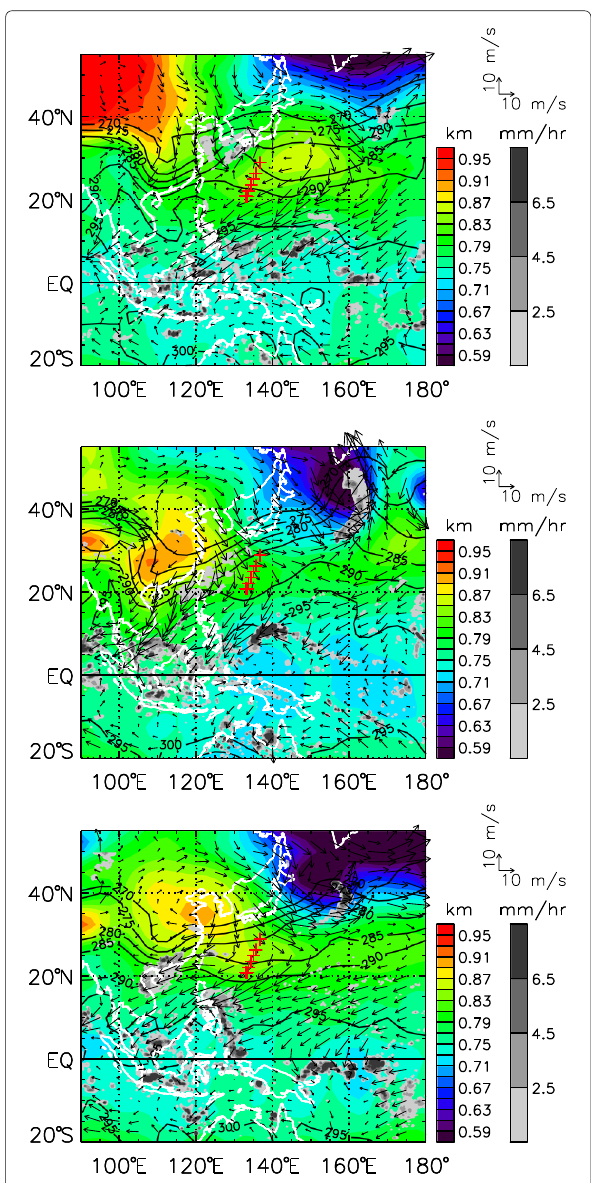
Fig. 2 Horizontal map of relevant meteorological variables during the Hakuho-maru observation period. The NCEP Reanalysis II geopotential height (color shading), temperature (Kelvin, black contours), horizontal wind (arrows), and TRMM 3B42 rainfall (gray shading) at the 925 hPa level at (upper) 1200 UT on December 21, (middle) 0600 UT on December 23, and (lower) 0000 UT on December 26, 2012. The launch sites of the radiosondes from the R/V Hakuho-maru are indicated by red pluses